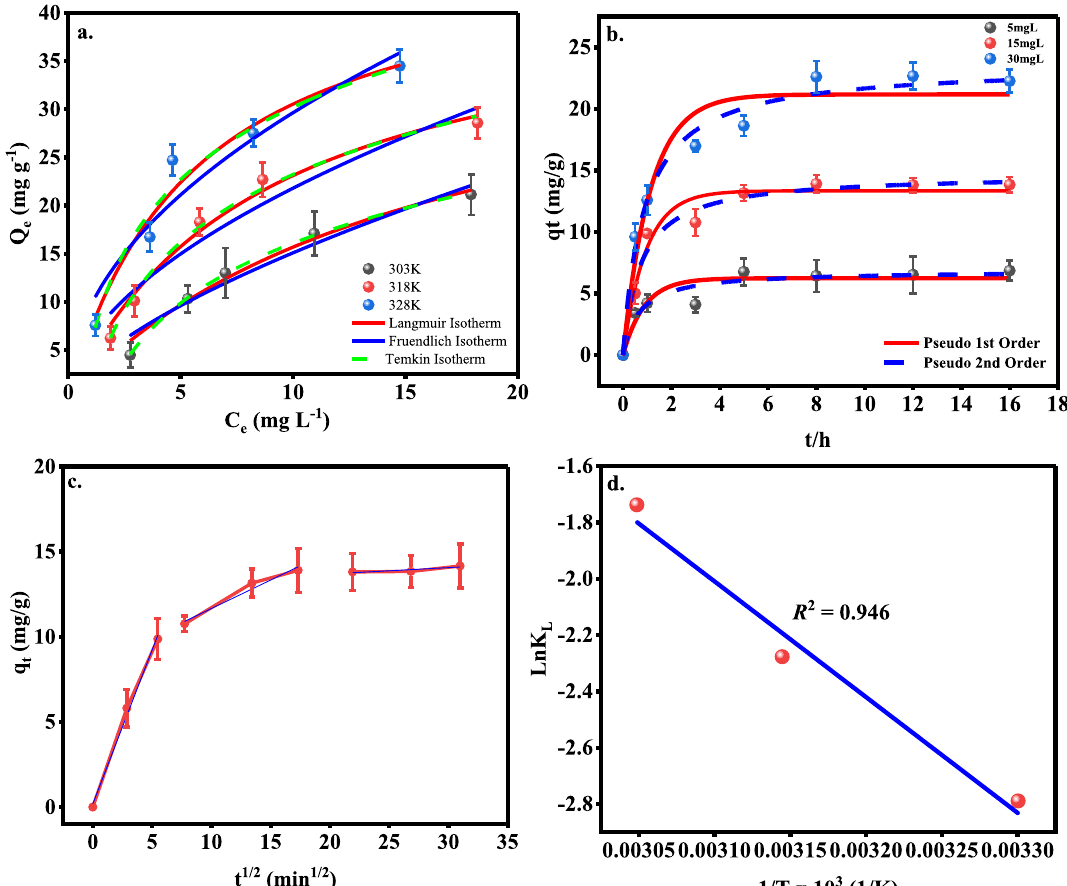
Fig. 4 a Adsorption isotherms. b Adsorption kinetics. c Morris Webber plot of intraparticle diffusion. d Thermodynamics plot of LnK L versus 1/